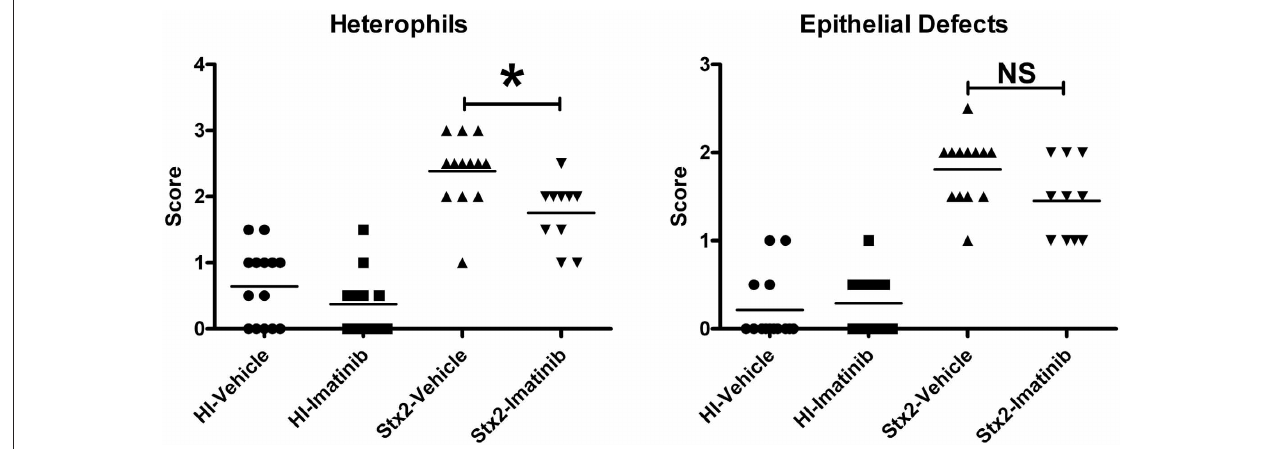
P -value = 0.0068; NS (not significant) P -value = 0.064. HI-vehicle n = 14, HI-imatinib n = 12, Stx2-vehicle n = 13, and Stx2-imatinib n =